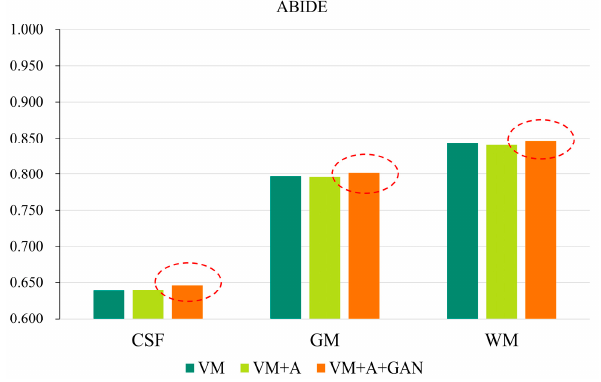
Figure 6. GAN registration performance on the ABIDE dataset.